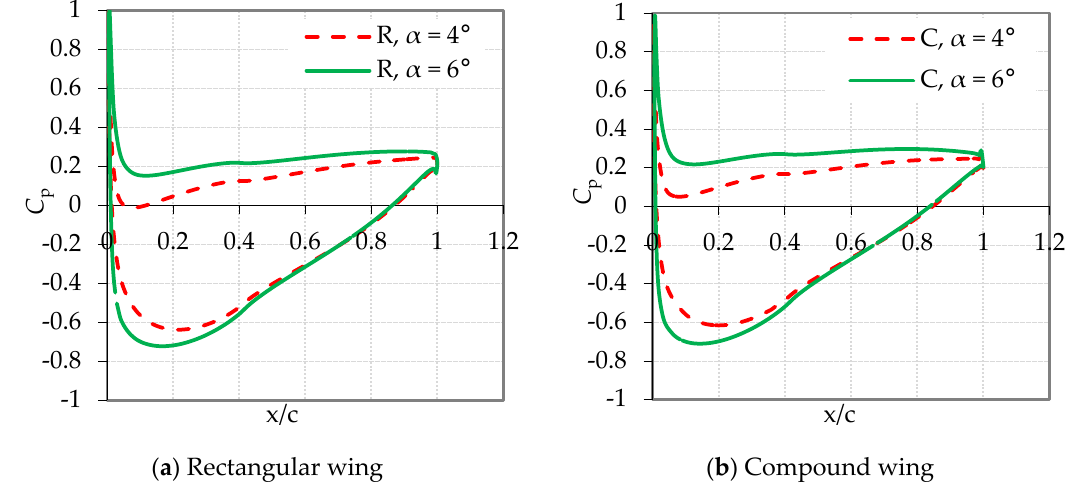
Figure 9. Pressure coefficient distribution ( C p) at the middle span of the rectangular wing ( a ) and the compound wing ( b ) at h/c = 0.15 for various attack angles ( α ).